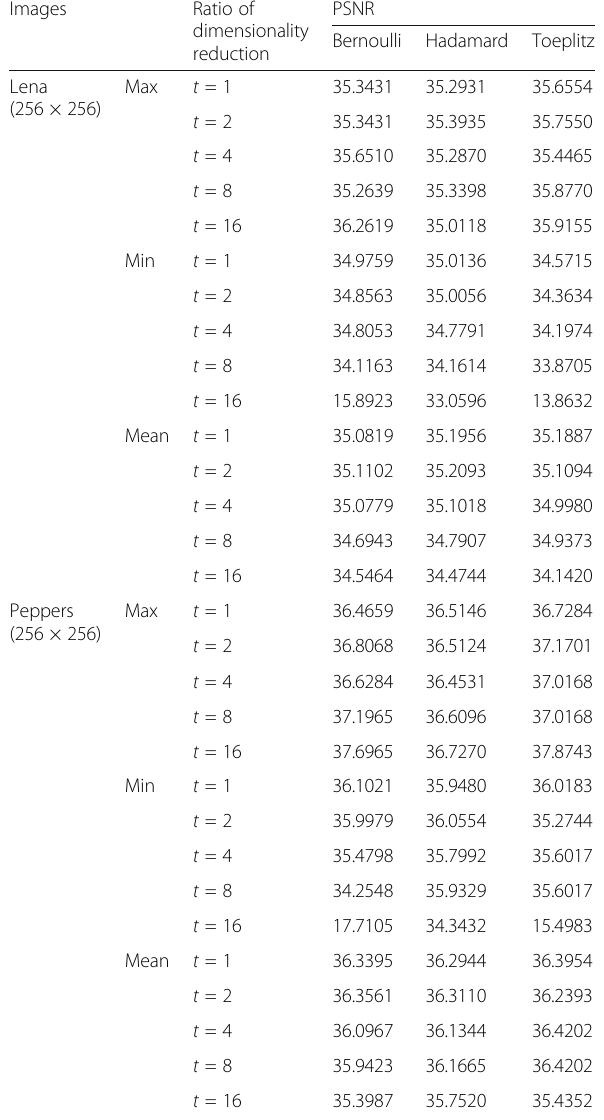
Table 4 Tests on other random measurement matrices with different dimensions. ( M / N = 0.5, ℓ 0 -minimization with ρ = 0.8) Images